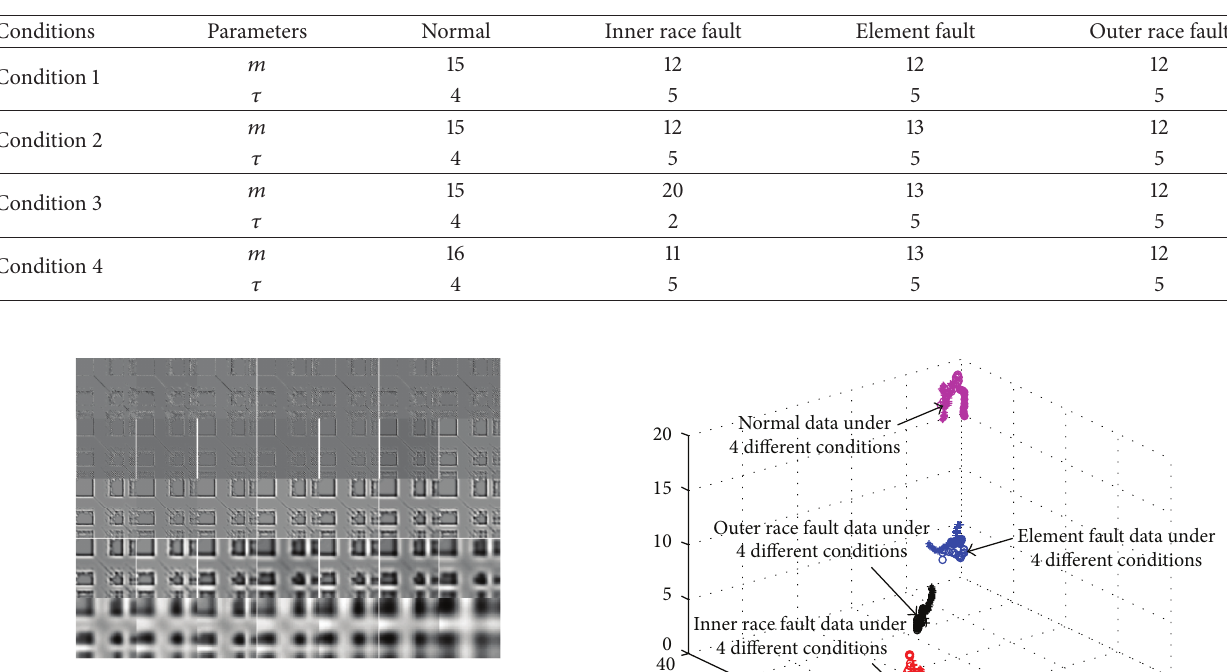
Table 2: The experiment parameters of each fault mode under different conditions.